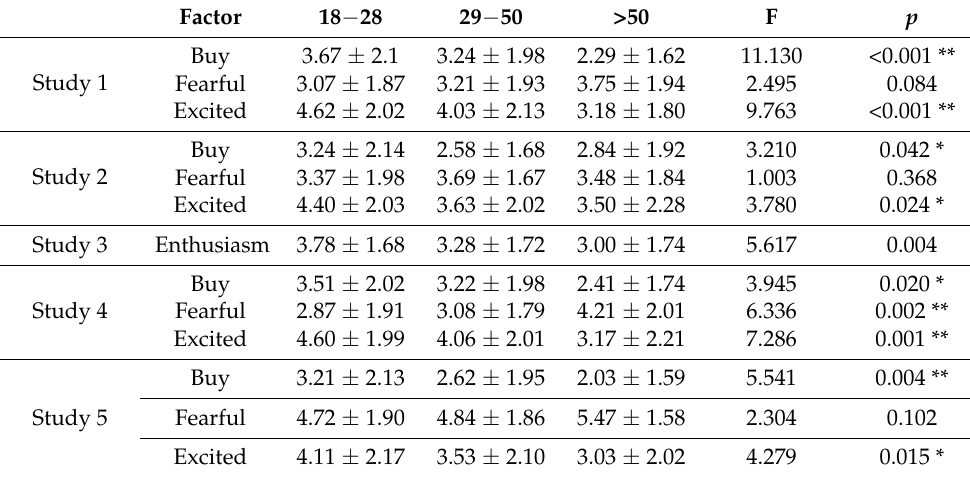
Table 8. ANOVA for